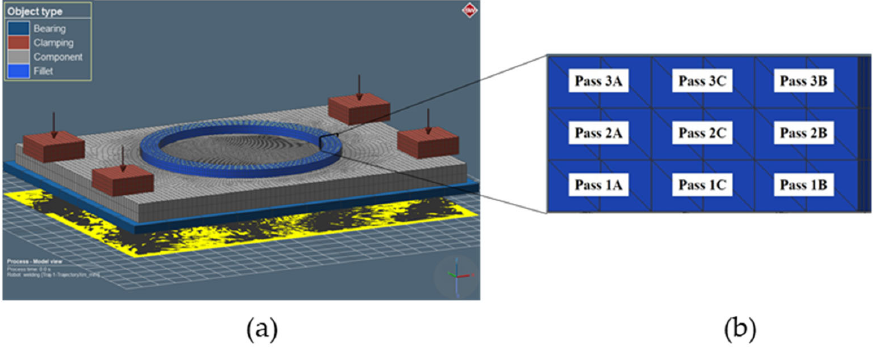
Figure 14. Weld-deposition modelling in Simufact: ( a ) Overall setup, ( b ) sectional view of the deposition passes.